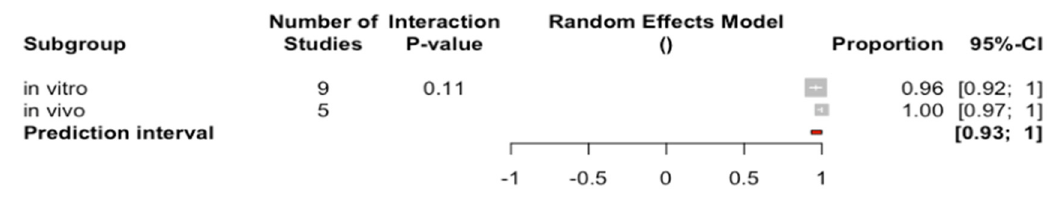
Figure 3. Forest plot of root canal location success rate compared between computer-aided navigation techniques. The horizontal axis expresses the root canal proportion success rate of each computer-aided navigation technique.